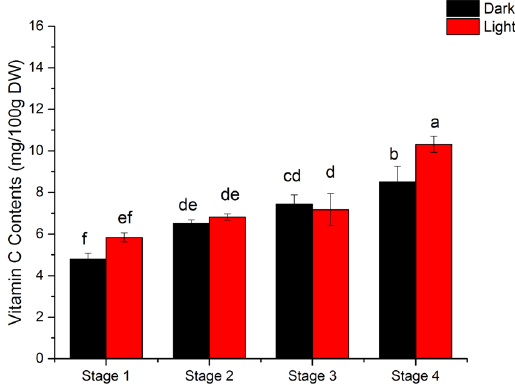
Figure 3. Changes of vitamin C during sweet corn seed germination; Bars with different letter indicates significant difference (p < 0.05) exists within groups.